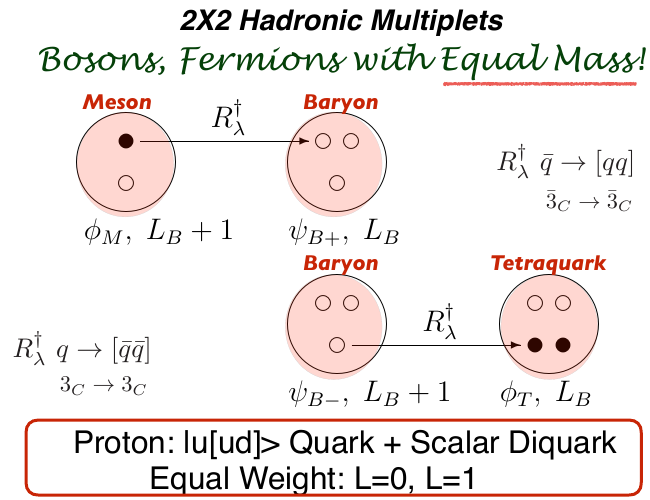
Figure 1: The supersymmetric quadruplet  M , B + , B ,  T . Open circles represent { }  quarks, full circles antiquarks. The tetraquark has the same mass as its baryon partner in the multiplet. Notice that the LF angular momentum of the negative-chirality component wave Figure 2. The 4-plet representation of mass-degenerate hadronic states predicted by superconformal function of a baryon B is one unit higher than that of the positive-chirality (leading-twist) algebra [15]. Mesons are q ¯ q bound states, baryons are quark—antidiquark bound states and tetraquarks  component B + . are diquark-antidiquark bound states. The supersymmetric ladder operator R † connects quarks and λ anti-diquark clusters of the same